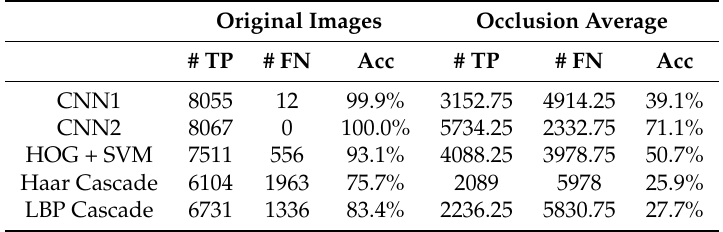
Table 5. Classification performance on the original images versus the occluded